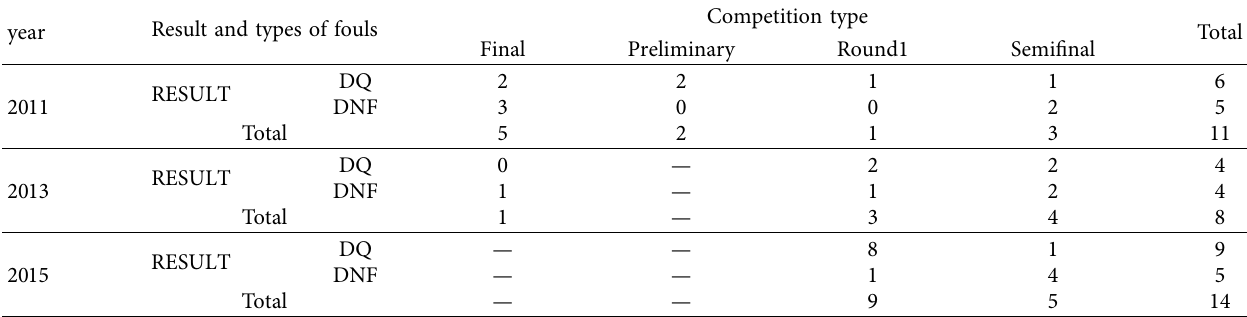
Table 11: Contingency table of foul type and round of competition.